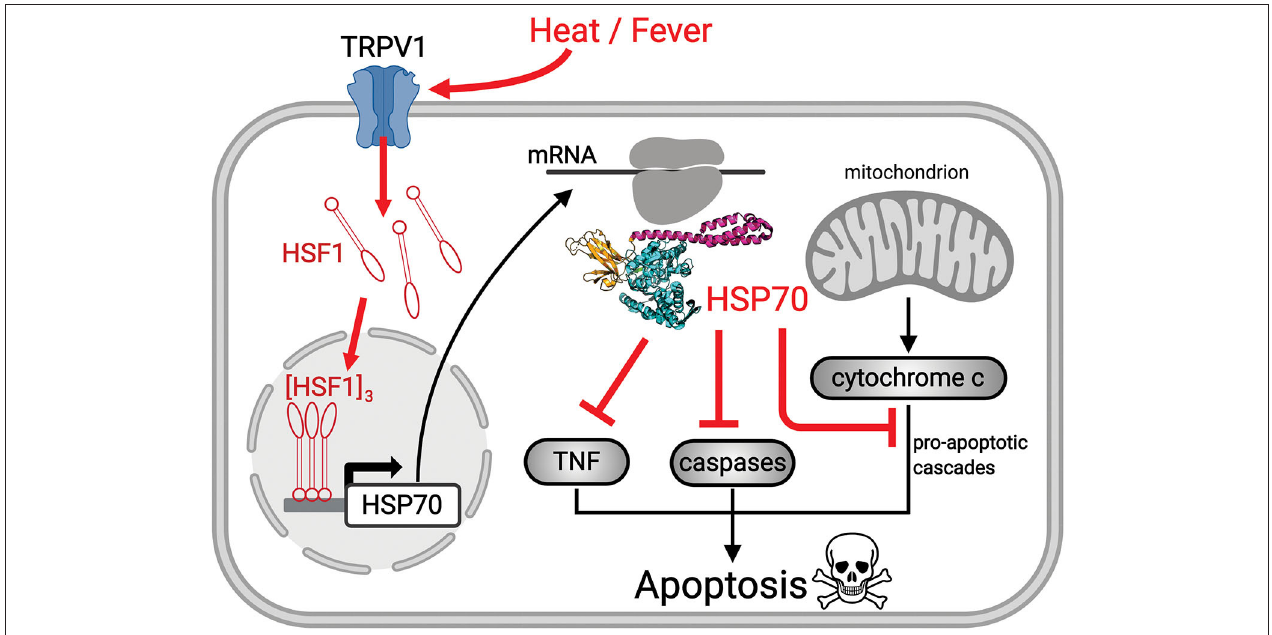
FIGURE 1 | Scheme showing the mechanism of heat-induced HSR and its protective effects. Upon heat-stress such as fever, the fluidized plasma membrane triggers the transient opening of heat sensory calcium channels, such as TRPV1. The ensuing specific calcium-mediated heat-shock signal induces the hyperphosphorylation of cytosolic inactive monomeric HSF1, that trimerizes and translocates to the nucleus where it binds promotor regions of HSP-encoding genes. The mRNA of HSP70 is translated in the cytosol into HSP70 acting to repress sepsis-induced ROS-mediated pro-apoptosis signals (red cross sticks), leading to survival of pre-existing alveolar type 1 cells and to the differentiation of alveolar type 2 cells, into functional, new alveolar type 1